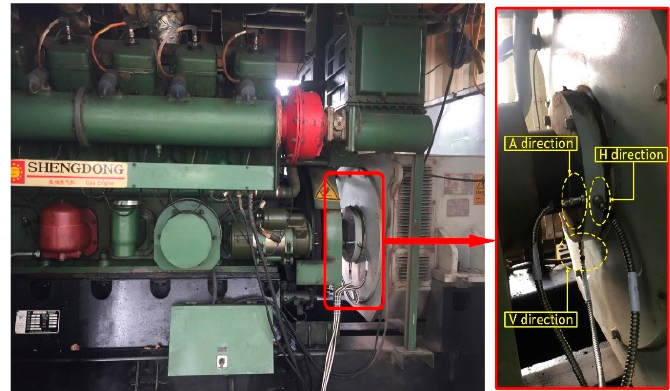
Figure 8. Landfill gas power generator.